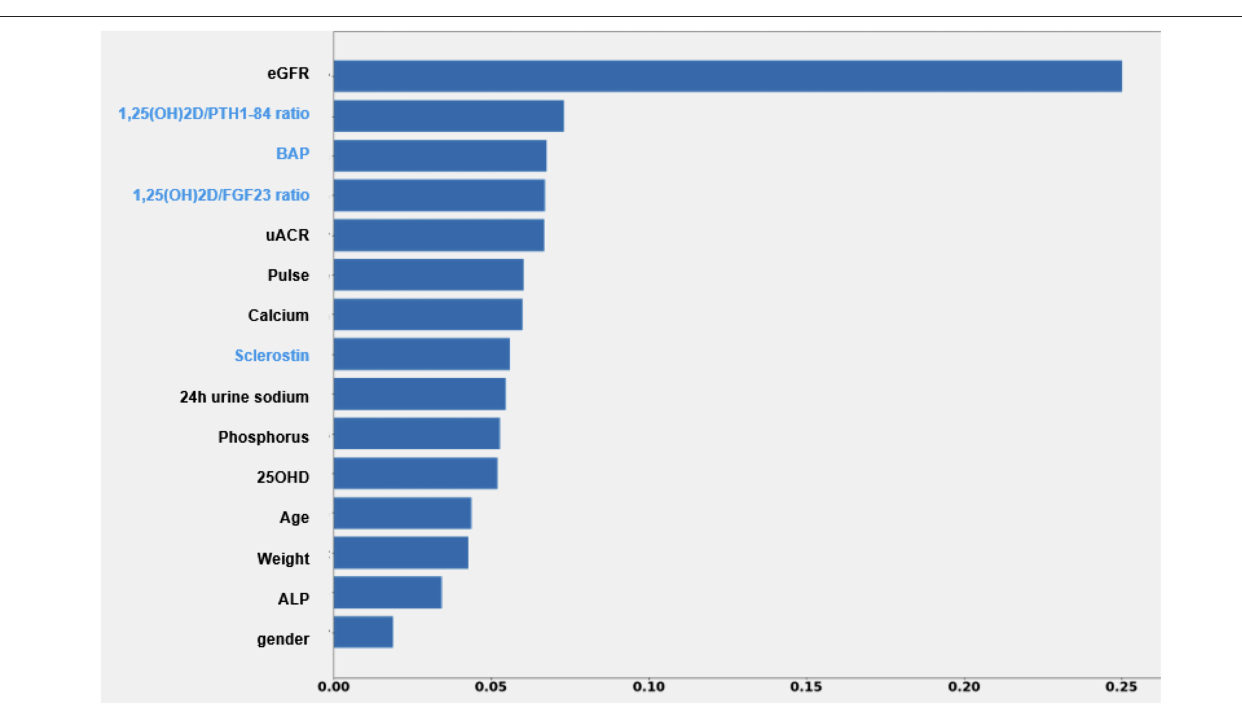
FIGURE 2 | Impact of each feature of the XGBoost model on the prediction of eGFR value after 3 months. Each importance score attempts to quantify the relative importance of each feature in the prediction of the output variable. ALP, alkaline phosphatase; BAP, bone specific alkaline phosphatase; eGFR, estimated glomerular filtration rate; UACR, urine albumin creatinine